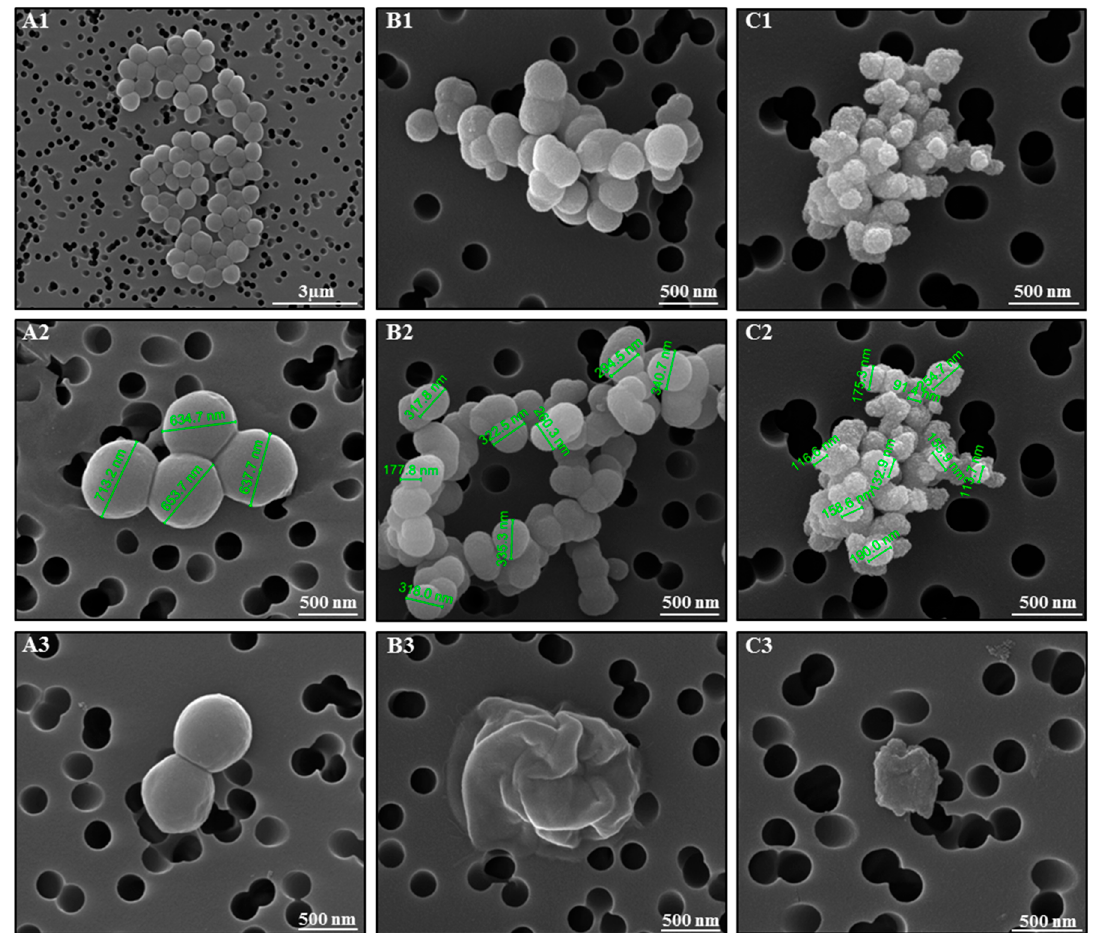
Figure 9. S. aureus morphology observed by SEM after incubation in growth medium in the absence ( A1 – A3 , control) and presence of compound 1 ( B1 – B3 , 48 µg/mL; C1 – C3 , 64 µg/mL) for 24 h.